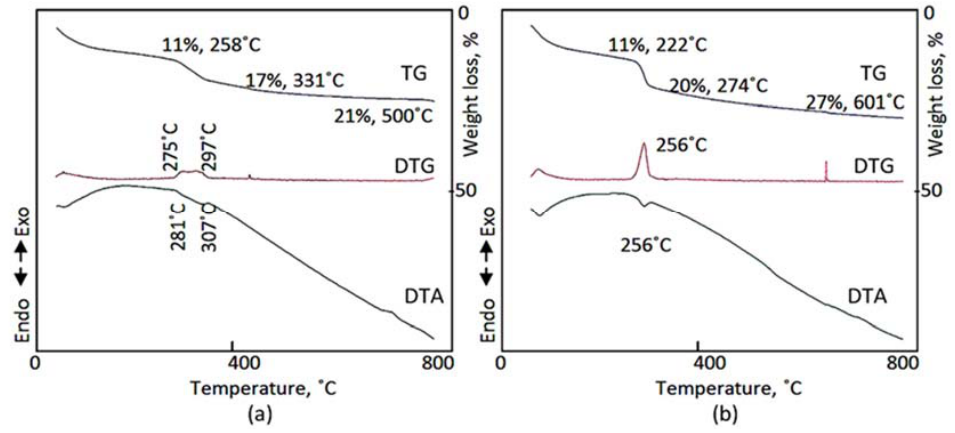
Figure 5. Thermal analyses of: ( a ) SiCo ‐ 1 ‐ 16; and ( b ) SiCo ‐ 1 ‐ 36. The DTA curve confirmed that by observing the endothermic peak at 80 °C, the water molecules which strongly bonded with the interlayered anions were lost at higher temperatures of 222–258 °C for both samples and were 3–4 wt%. The decomposition of the interlayered anions of sample SiCo ‐ 1 ‐ 16 happened in two steps. The first step was 6 wt% and occurred at 331 °C. The second step was 4 wt% and took place at 500 °C. The DTG curve revealed two peaks at 275 °C and 297 °C, confirming the presence of two in ‐ terlayered anions. Additionally, the dual interlayered anions were confirmed by DTA curve. However, in the case of sample SiCo ‐ 1 ‐ 36, the first anion 9 wt% was sharply lost at 274 °C, exhibiting an endothermic peak in the DTA curve and a sharp peak in the DTG curve at 256 °C. Meanwhile, the second anion 7 wt% was gradually lost at up to 601 °C with the dihydroxylation process of the nanolayers. These results concluded that the nanofibers of Si/Co LDH formed after 26 h of reaction time. During this time, the dual anions of cyanate and nitrate intercalated with a large amount of water inside the inter ‐ layered space. 3.5. Formation Mechanism of One ‐ Dimensional Nanofibers The usual geometry and morphology of Co ‐ Al LDHs are two ‐ dimensional layered structures with a hexagonal shape [42]. In the current structure, a one ‐ dimensional structure was observed for Si/Co LDHs. According to the difference between the usual LDHs and the current LDHs, the mechanism of conversion from a 2D material to a 1D structure can be applied for explaining this behavior. The current Si/Co LDH creates cationic nanolayers with positive charges (+2) on silicon because of the combination be ‐ tween the divalent cobalt and the tetravalent silicon. In addition, the FI ‐ IR results and thermal analyses confirmed the presence of cyanate anions (CNO ‐ ) and nitrate anions which can be used as pillars for building the LDH structure and neutralizing the positive charges (+2) of the nanolayers of Si/Co. These cyanate anions were produced through urea hydrolysis while the nitrate anions were released from the precursor of cobalt. Urea is a very weak Bronsted base (pK b = 13.8). By controlling the temperature, urea is slowly hydrolyzed and decomposed to form ammonium cyanate, converting the medium of the reaction from an acidic nature (pH = 3) to alkaline nature (pH = 8). This process needs a long time to produce enough amounts of cyanate anions in addition to achieving an alkaline medium for precipitating LDHs. Therefore, SEM im ‐ ages showed that the better quality of nanofibers was obtained after 26 h of the reaction. The positive charges (+2), which produced from the combination between cobalt and sil ‐ icon, attracted the cyanate anions and/or nitrate anions which were identified by FTIR and thermal analyses. The comparison between the structure and the size of both nitrate and cyanate anions indicated that the intercalation of cyanate anions to build LDHs is